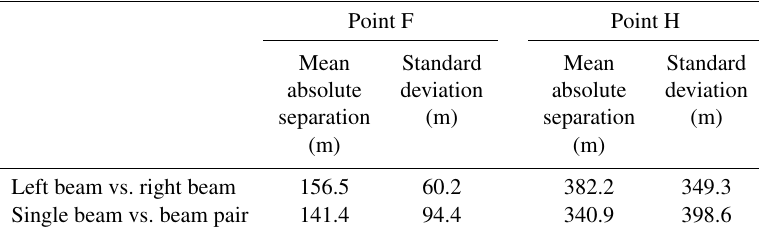
Table 1. Mean absolute separations and standard deviations between the GZ features calculated from the single-beam repeat-track data group and beam pair repeat-track data group.